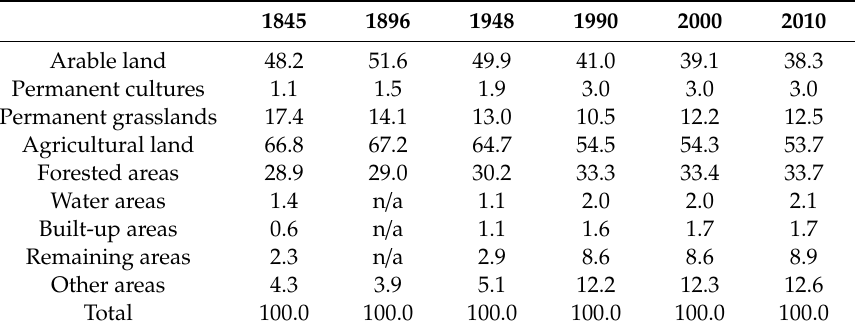
Table 2. Land use changes in Czechia 1845–2010